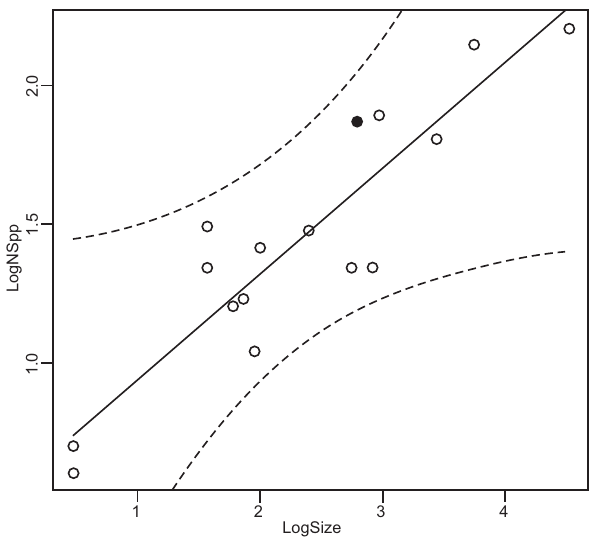
Figure 2. Regression curve of the species-area relationship (Log- transformed) of the bird richness and island size in offshore is- lands in the coast of Brazil. Dot lines are confidence intervals and the black dot is the Anchieta Island.